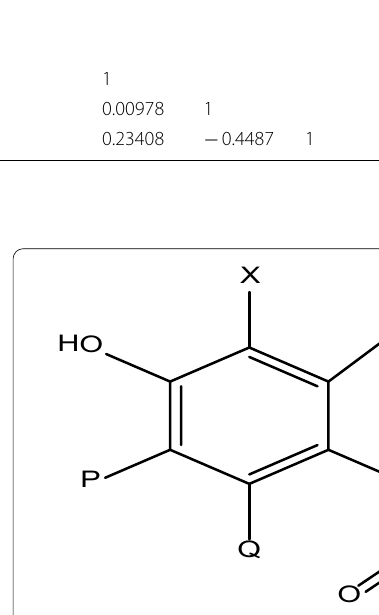
Fig. 4 2D structure of Ligand template